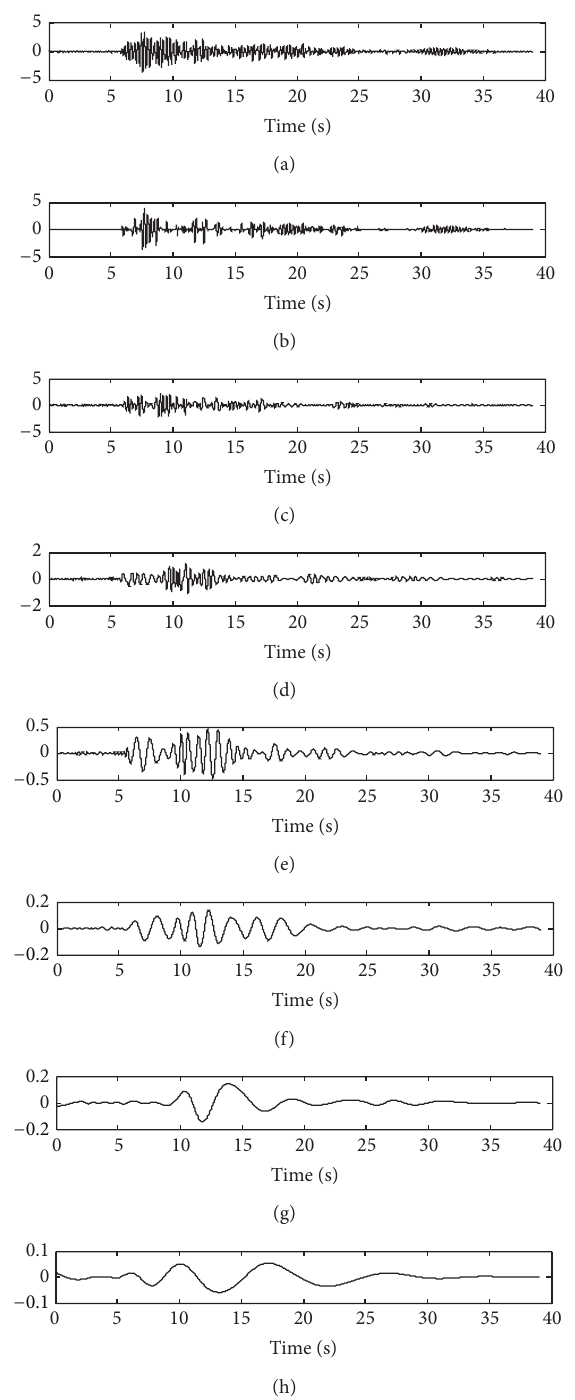
Figure 4: Extracted IMFs of the acceleration response.